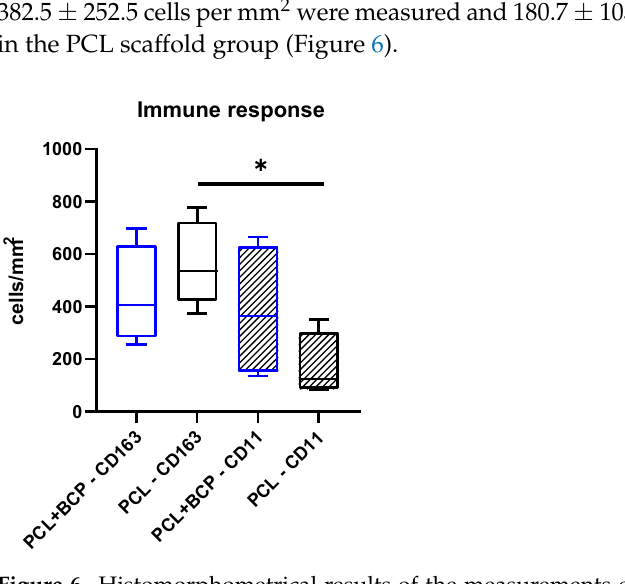
Figure 5. Representative images of the inflammatory tissue reactions to the scaffolds within the subcutaneous connective tissue (CT) at day 15 post implantationem. ( A ) CD163 detection and ( B ) CD11c detection within the implantation beds of the PCL scaffolds combined with the BCP gran- ules (PCL+BCP and asterisk in ( A )). ( C ) CD163 detection and ( D ) CD11c detection within the im- plantation beds of the pure PCL scaffolds. Red arrows = positive macrophages, white arrows = negative macrophages, red arrowheads = positive multinucleated giant cells, white arrowheads = negative multinucleated giant cells (immunostainings, 400× magnifications, scalebars = 10 µm).